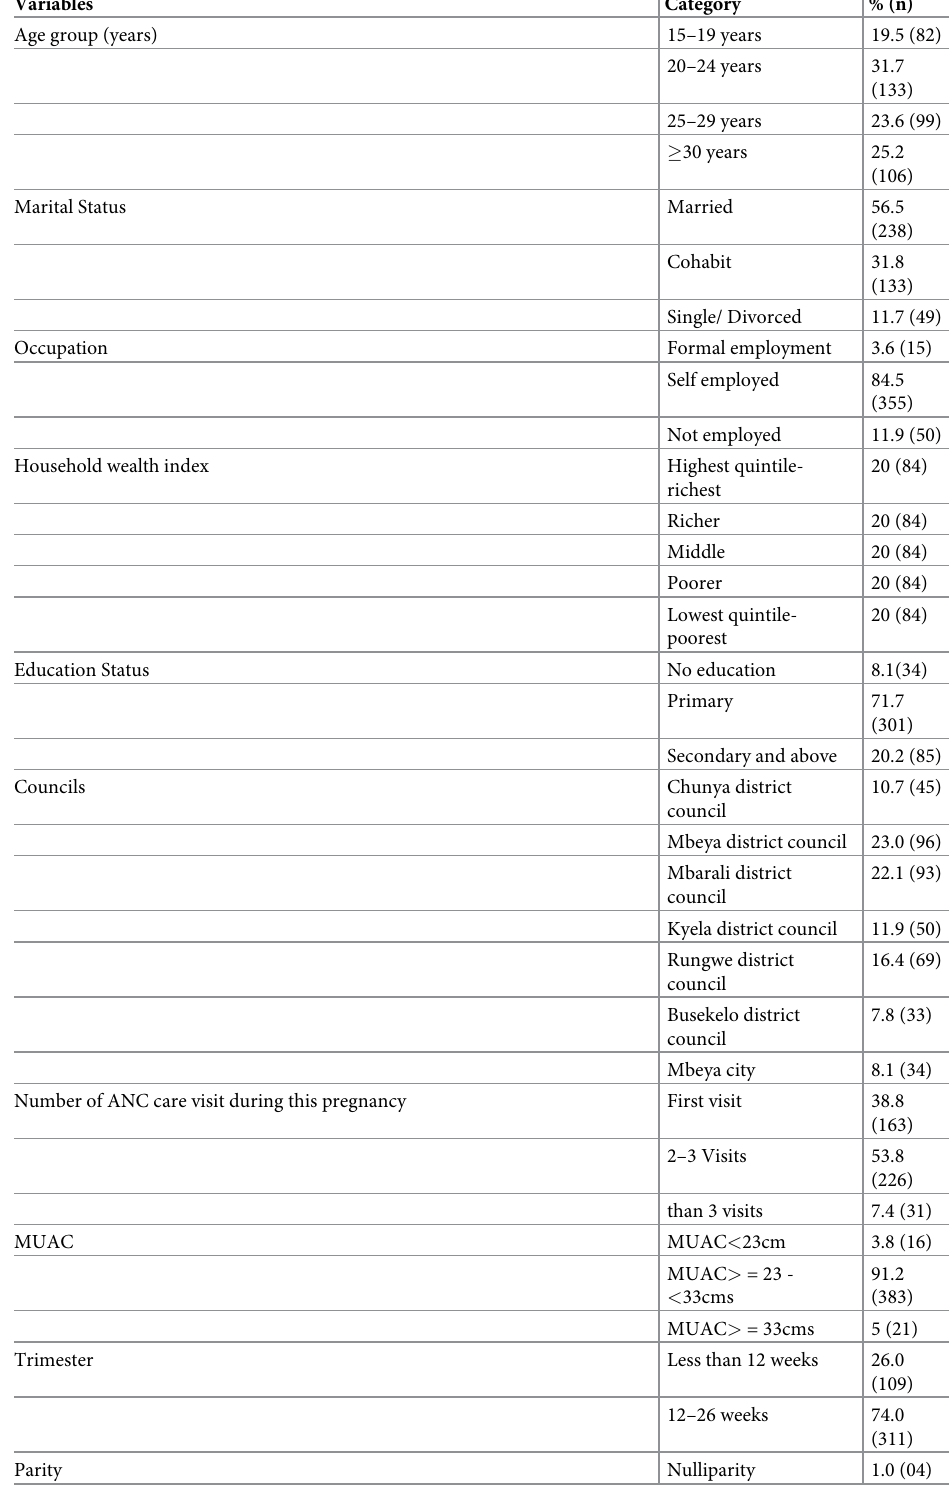
Table 2. The socio-demographic reproductive health, and nutrition characteristics among pregnant women attending Antenatal clinics in Mbeya, Tanzania (n =